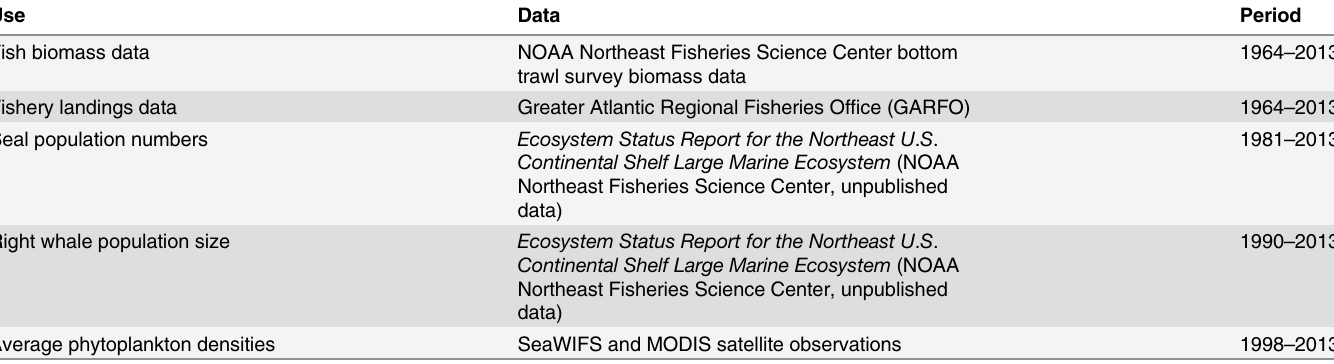
Table 1. Data uses, sources and years for which data are available that were collated and used as the observed data set in the model skill analysis.